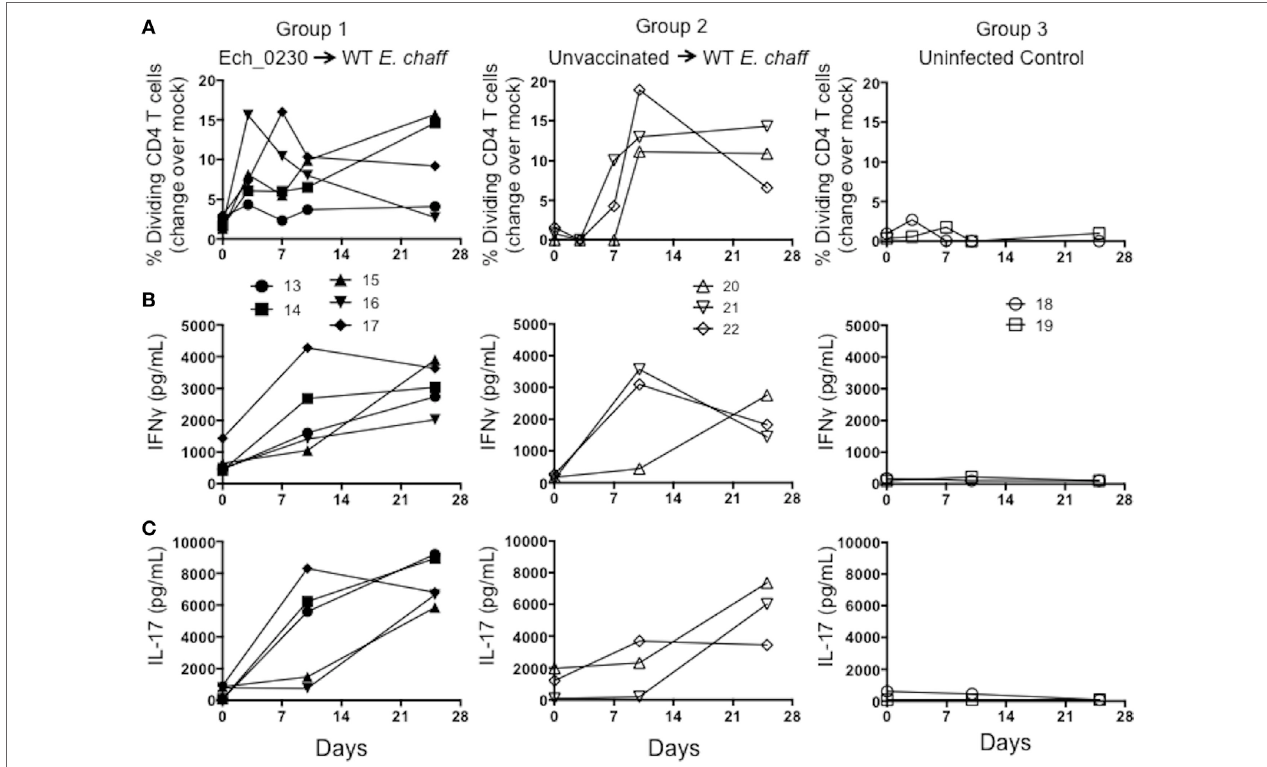
FigUre 2 | Cellular immune responses in dogs vaccinated with the Ech_0230 mutant and challenged with wild-type Ehrlichia chaffeensis . Peripheral blood mononuclear cell from dogs vaccinated with the Ech_0230 mutant and challenged with wild-type E. chaffeensis (group 1), unvaccinated control dogs that were infected with wild-type E. chaffeensis (group 2), and uninfected negative control dogs (group 3) were labeled with Cell Trace Violet, then cultured for 5 days at 4 × 10 5 cells/well in the presence or absence of 10 μ g/mL E. chaffeensis host cell-free lysate grown in the tick ISE6 cell line. On day 5, single-positive CD4 + T cells were analyzed by flow cytometry for Cell Trace Violet dilution as a measure of proliferation. (a) The percentage of CD4 + T cells that have proliferated in response to E. chaffeensis antigens as measured over the course of the experiment. The background (mock stimulated) proliferation was subtracted, and results represent change over mock. (B,c) Cell culture supernatants from the stimulated cell cultures were analyzed by commercial ELISA kit for (B) IFN γ and (c) IL-17. Each line is representative of a single animal. (a–c) The data are not significantly different between groups as determined using two-way ANOVA with Sidak’s multiple comparisons